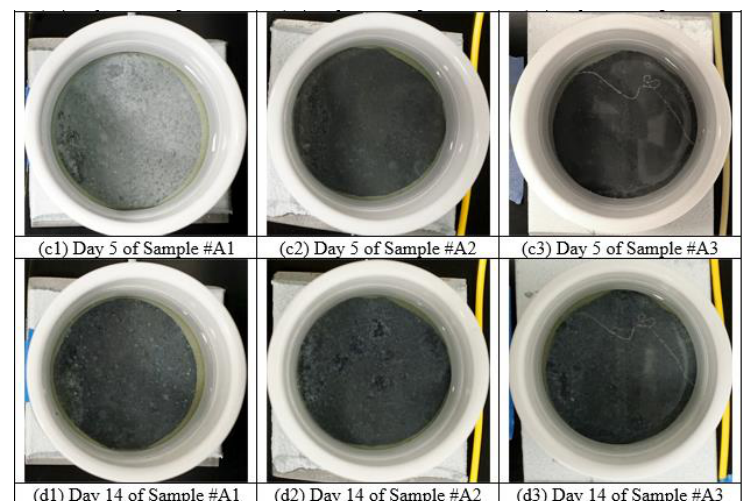
Figure 12. Visual inspection results for Samples #A1–A3.